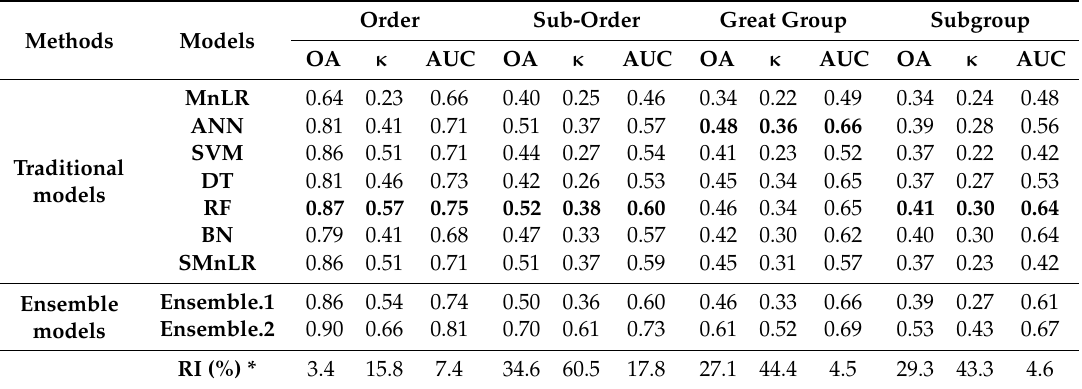
Table 3. Validation criteria of all models to predict soil taxonomy classes. Values highlighted in bold represent results with the largest accuracy.